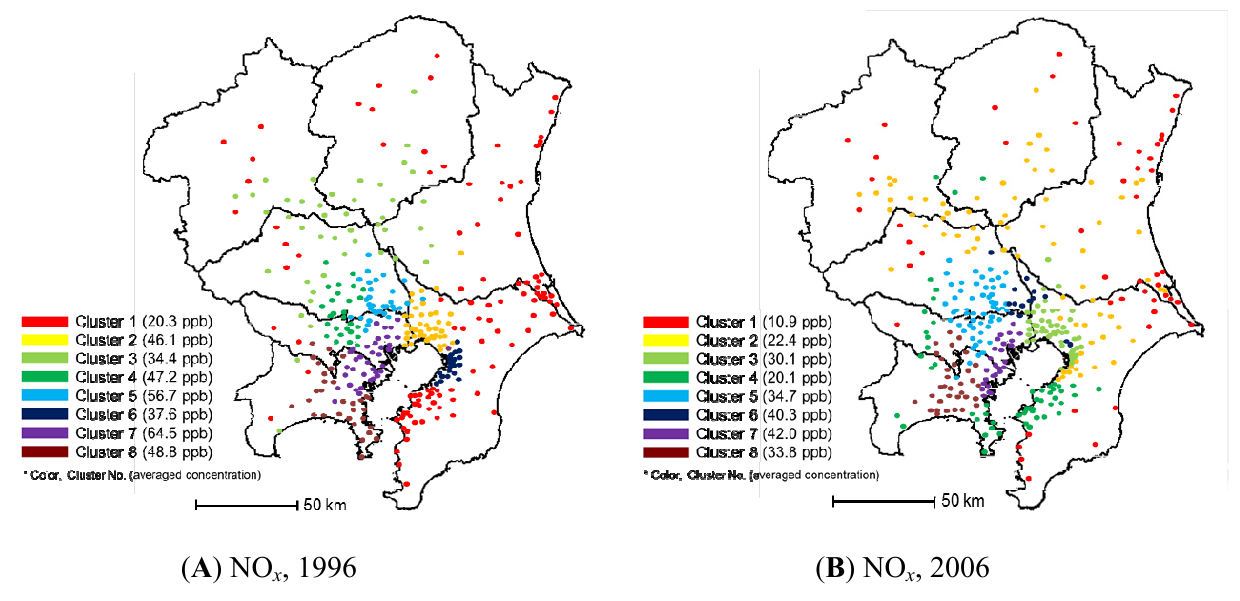
Figure 2. Results of clustering using NO air monitoring stations: ( A ) in 1996 and ( B ) in 2006.